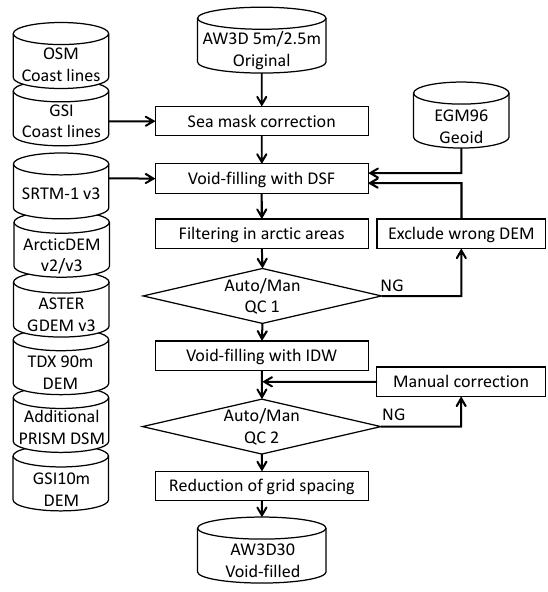
Figure 8. Processing flow of the AW3D